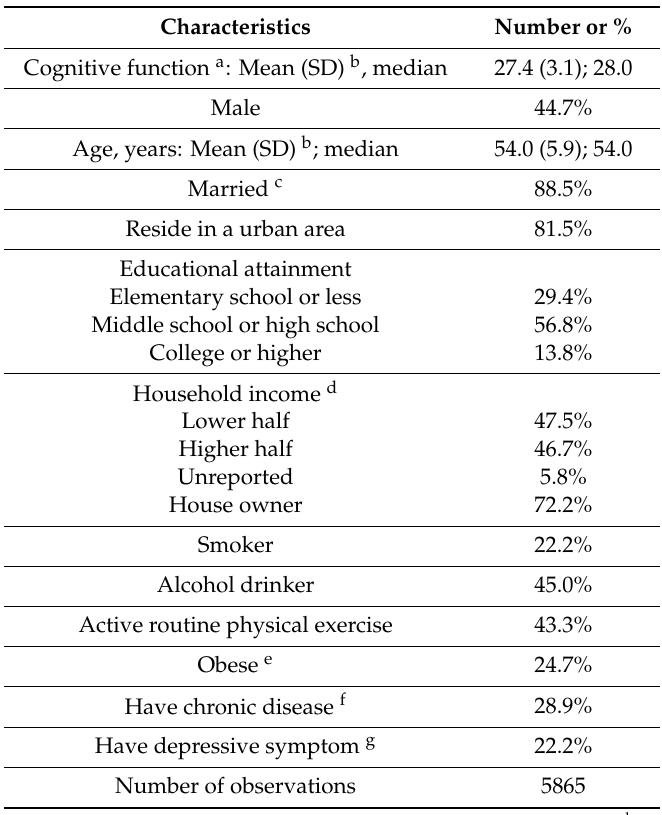
Table 1. Sample characteristics at